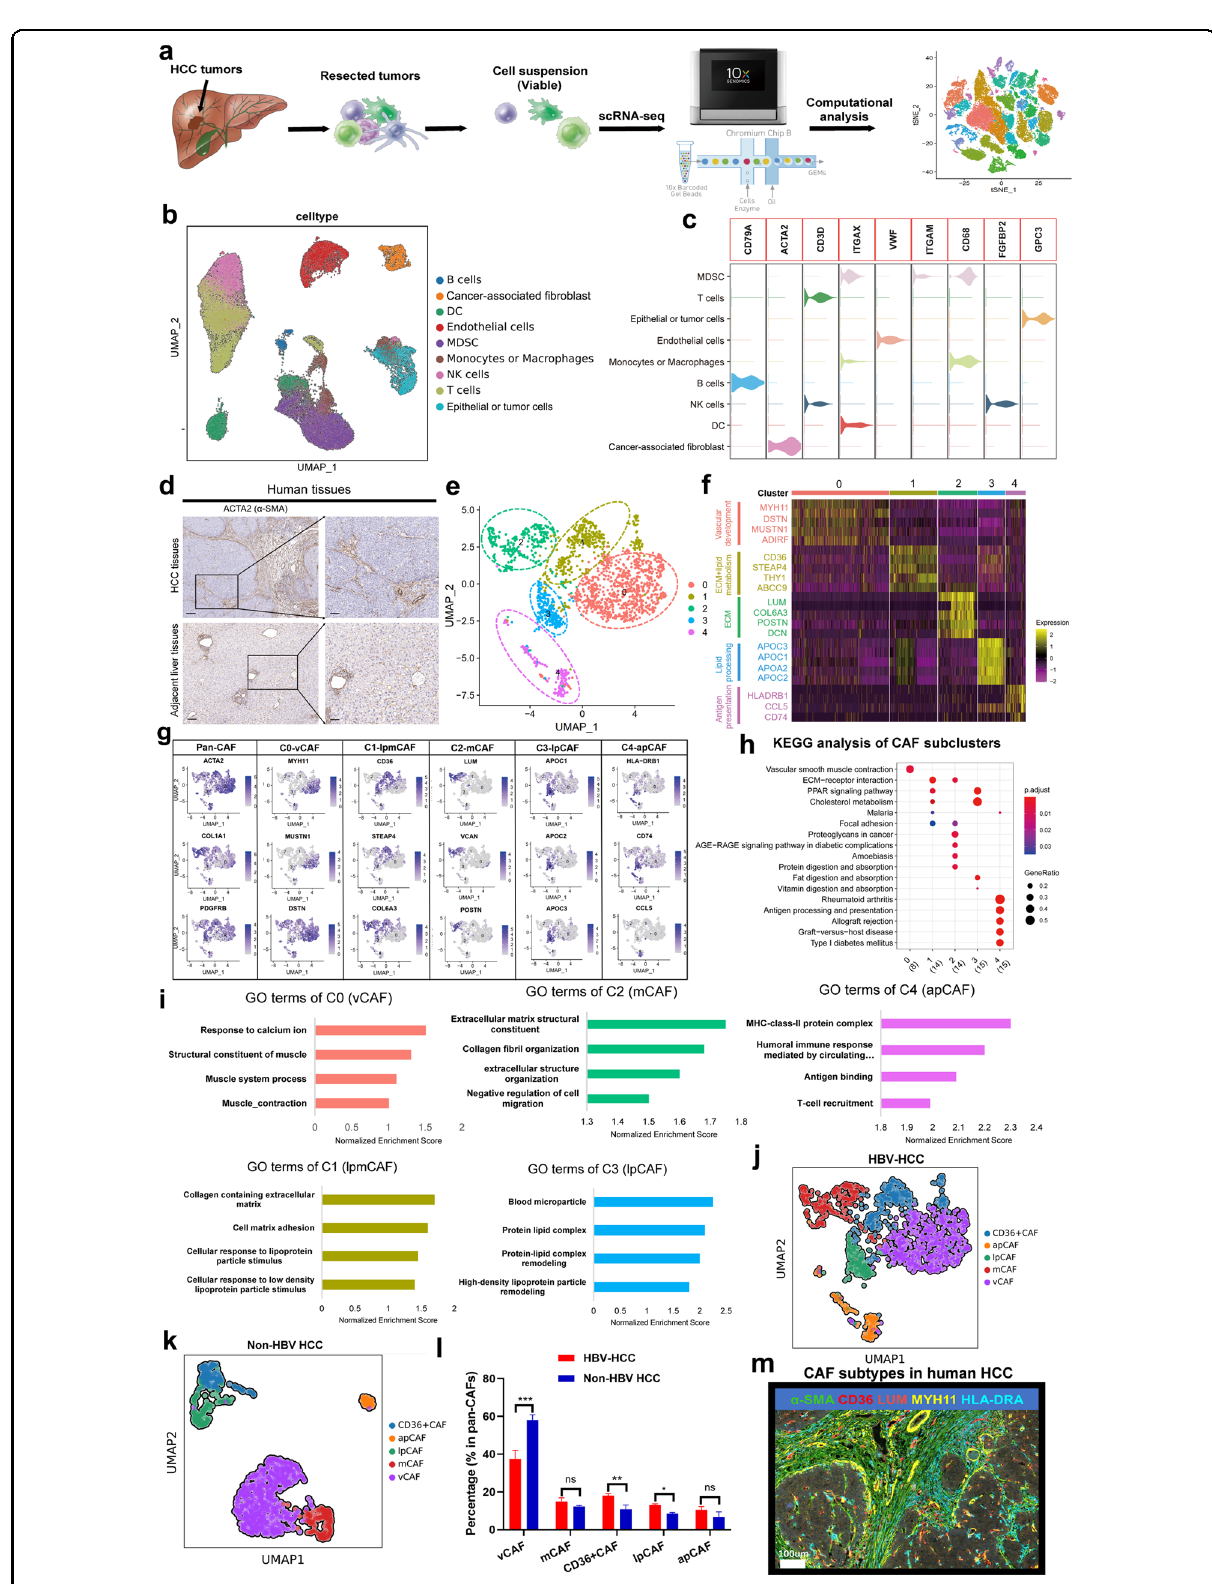
Fig. 1 (See legend on next